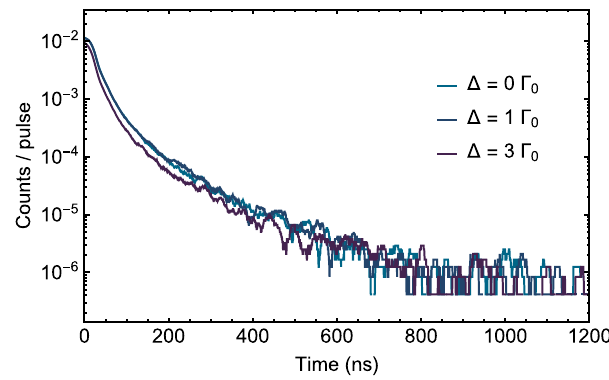
FIG. 6. Photon-count traces acquired as a function of the excitation frequency. The experimental data have been acquired in the shallowest trapping geometry described in the main text with N ≃ 4500 . The temporal traces have been divided by the number of pulses of light used; thus, they represent the mean number of photons collected during one pulse of resonant light.